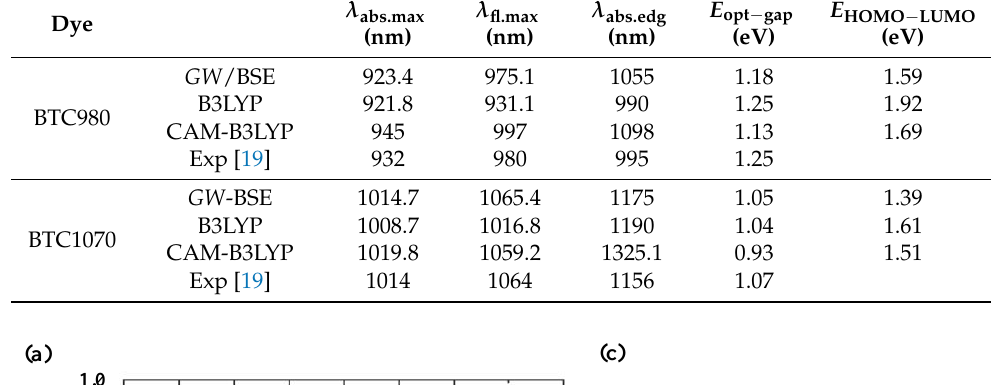
Table 1. Calculated maximum absorption wavelength ( λ abs.max ), emission wavelength ( λ fl. max ), and electronic transition composition for all structures computed in GW-BSE, B3LYP calculations, and the comparison with the experimental references.